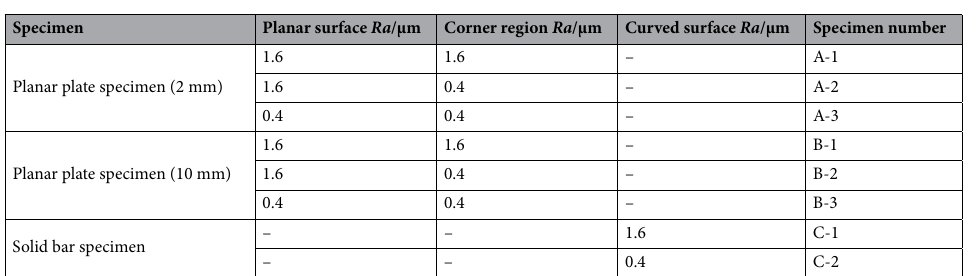
Figure 1. Geometry and dimension of the tested specimens: ( a ) solid bar specimen, ( b ) planar plate specimen. (Unit: mm).